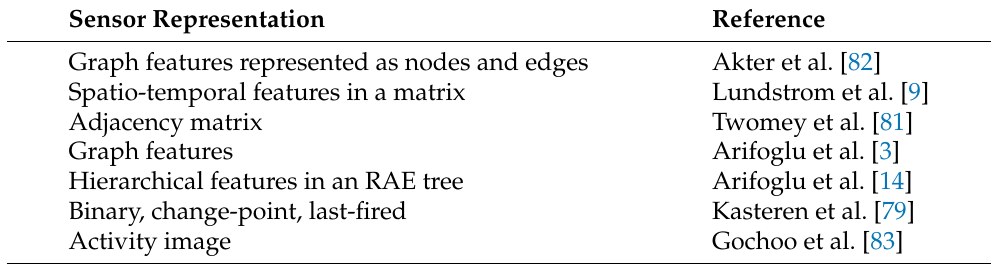
Table 6. Sensor representations.